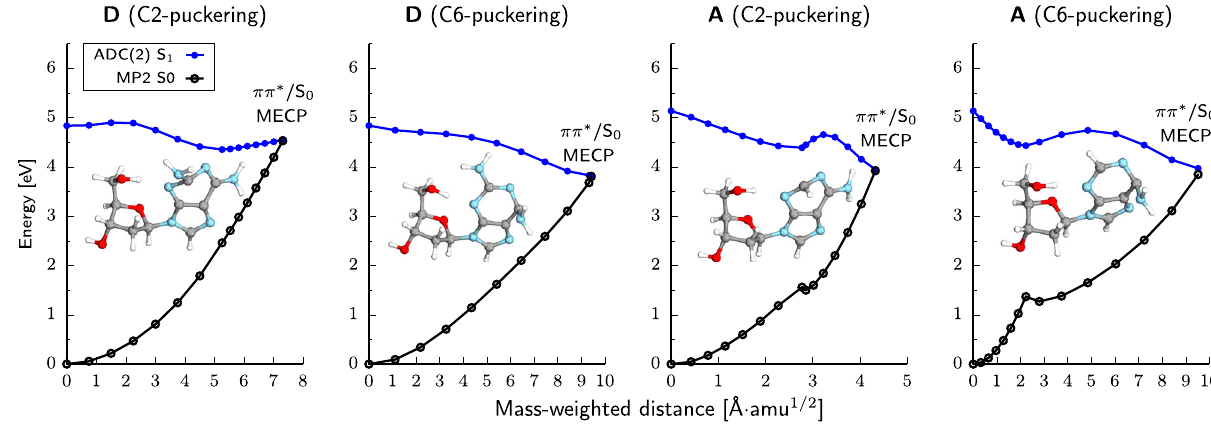
Fig. 6 Potential energy pro fi les for the key photorelaxation mechanisms of 2,6-diaminopurine and adenine 2 ′ -deoxyribosides (D and A). The electronic-structure calculations for ground and excited states were performed at the MP2 and ADC(2) levels, respectively, using the TZVP basis set. MECP minimum-energy